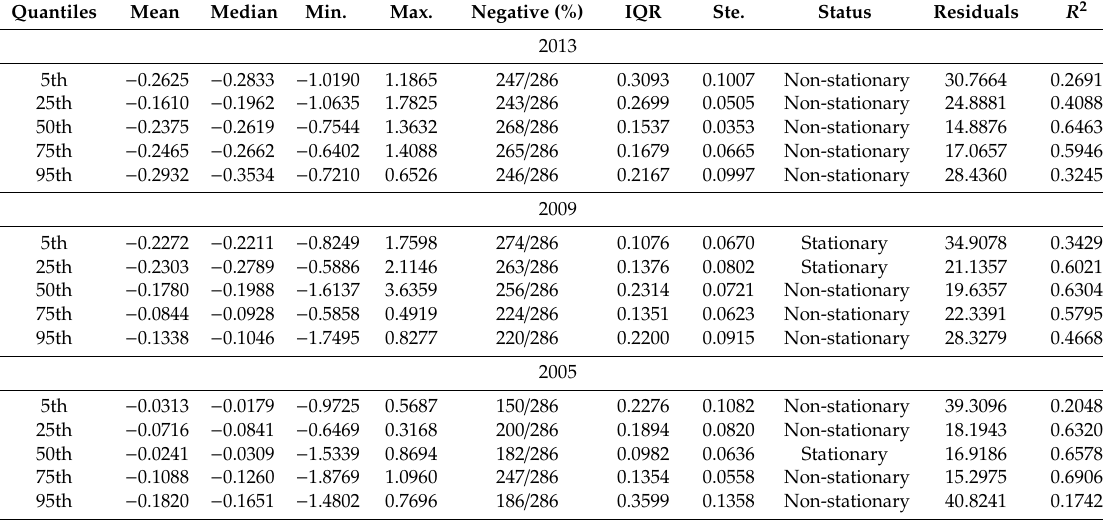
Table 4. Summary statistics of geographically weighted quantile regression (GWQR) estimate coe ffi cients of PM2.5 for